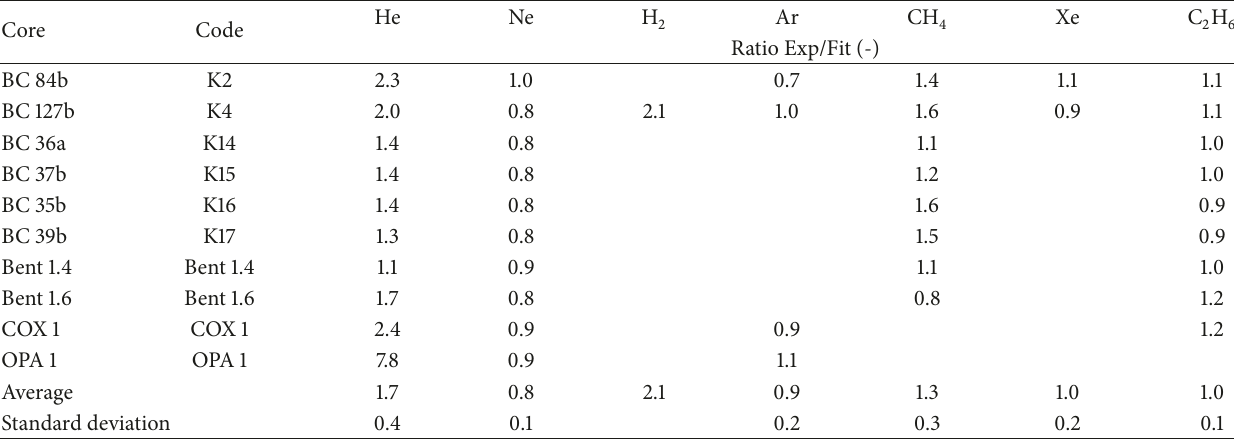
Table 8: Ratios between the experimentally determined 𝐷 eff (values see Table 4) and the fitted 𝐷 eff (using the fits given in Table 6), as well as the averages for each element. Due to the deviating value of He for sample OPA1, the corresponding 𝐷 eff is not included in the average. Core